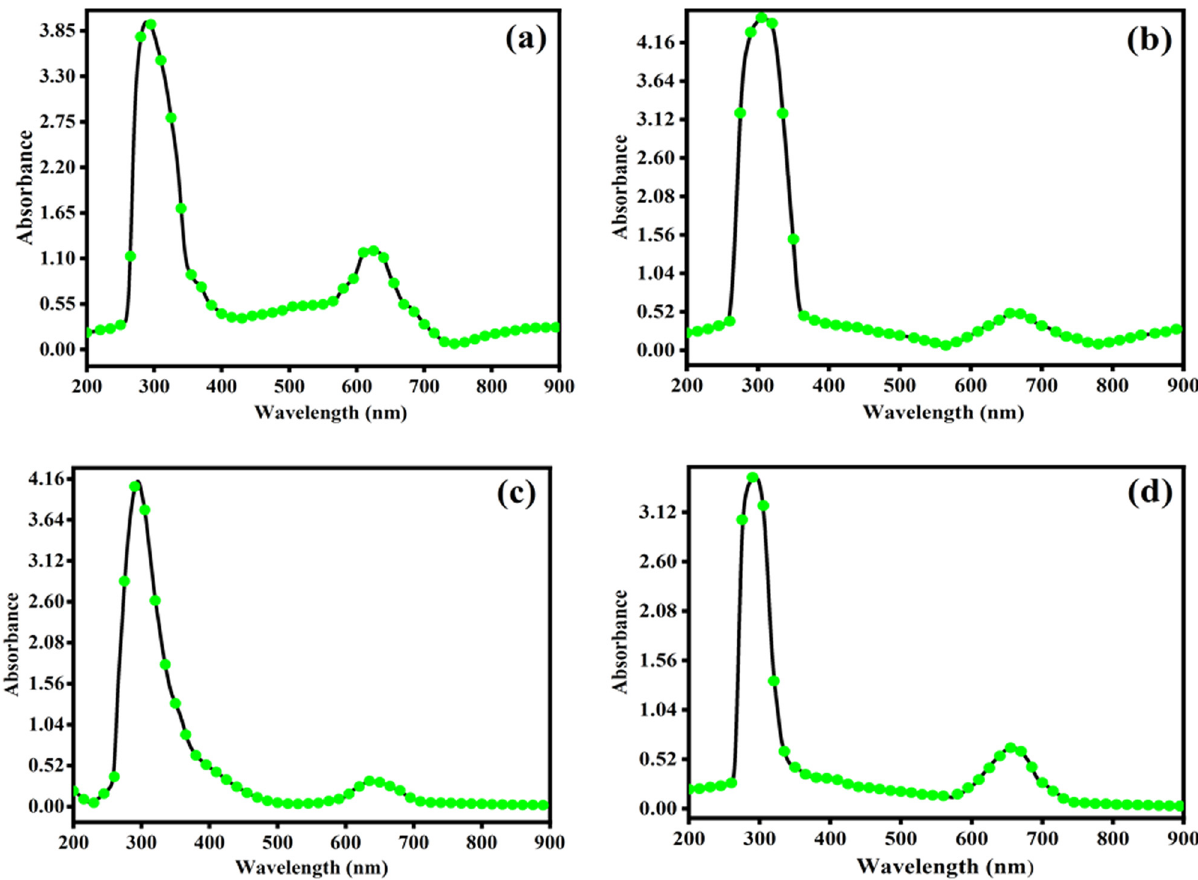
Figure 1: Electronic spectra of ( a ) [ CoL ( ac ) 2 ] , ( b ) [ NiL ( ac ) 2 ] , ( c ) [ CuL ( ac ) 2 ] , and ( d ) [ CuL ( fms ) 2 ] metal